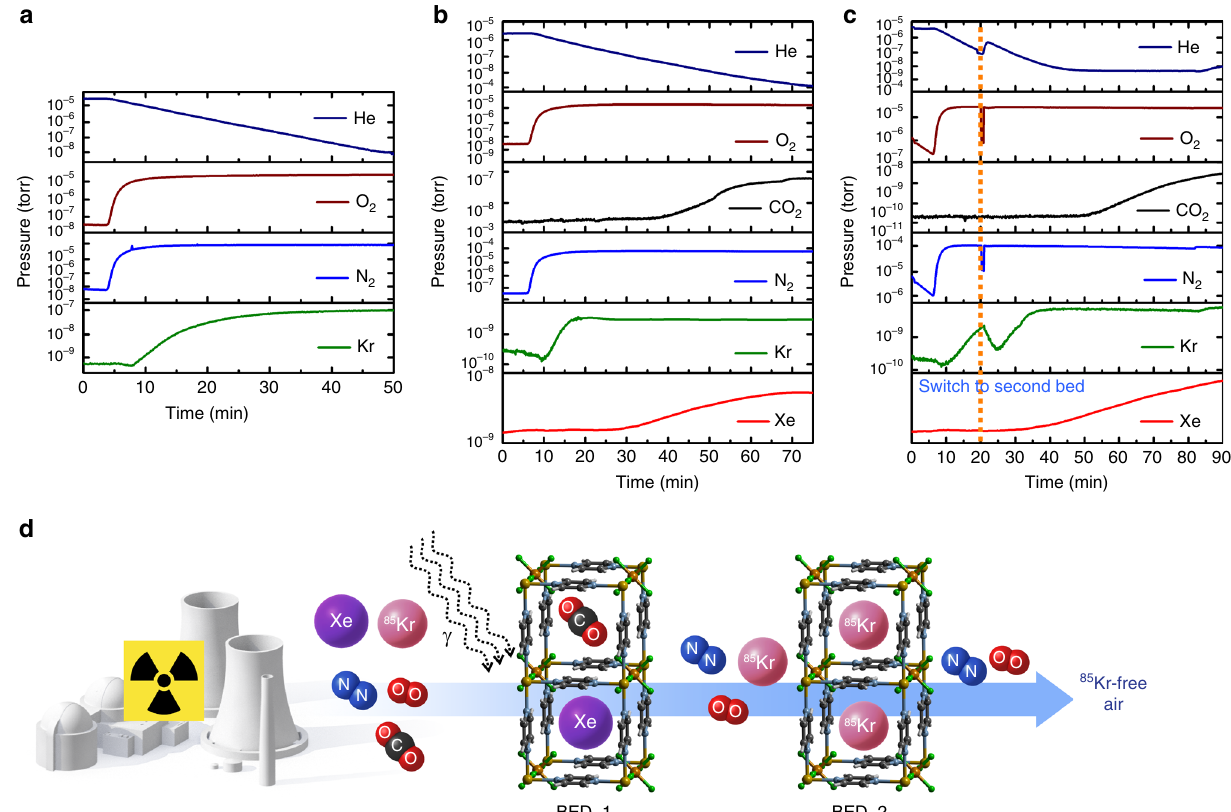
Fig. 5 Breakthrough curves for SIFSIX-3-Cu. a Single-bed breakthrough experiment using 1000 ppm Kr balanced with dry air. b Single-bed breakthrough experiment using 400 ppm Xe and 40 ppm Kr balanced with dry air. c Two-bed breakthrough experiment using 400 ppm Xe and 40 ppm Kr balanced with dry air. d schematic demonstration of the concept of the two-bed technique for the 85 Kr removal from the UNF.